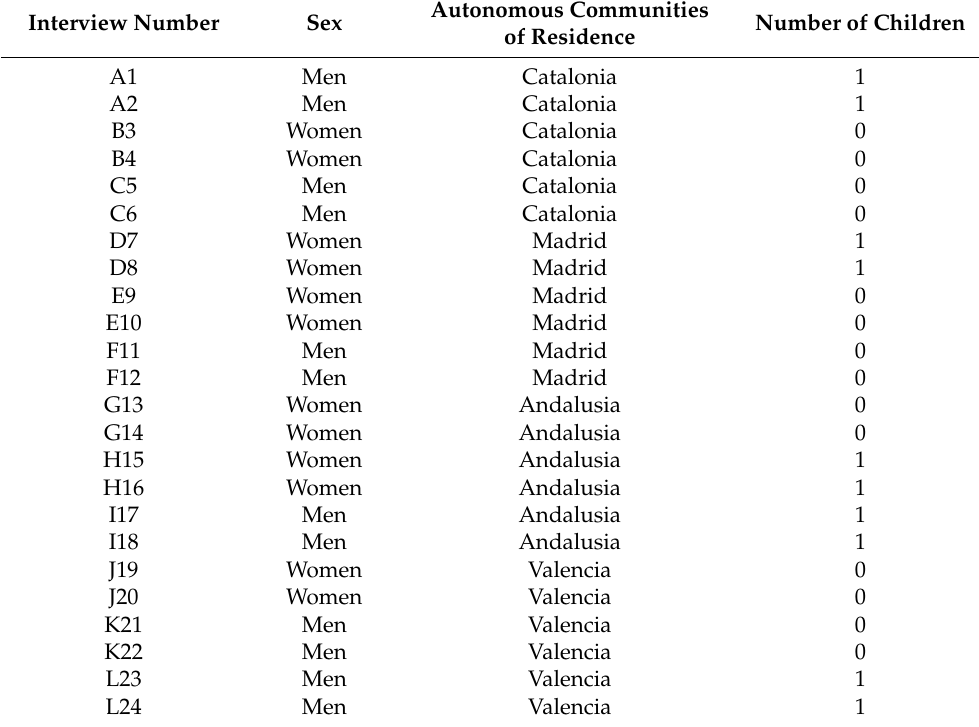
Table 2. Characteristics of the people